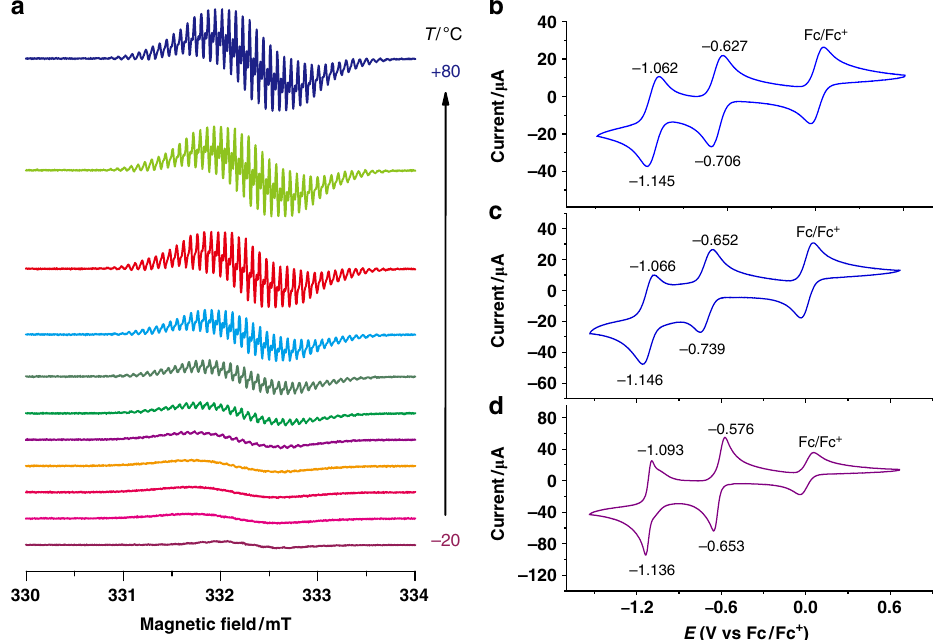
Fig. 5 EPR characterization. a EPR Spectra recorded in 10 degree interval on a 1:1 molar mixture of CBPQT 2( + (cid:129) ) and 1 2( + (cid:129) ) (0.50 mM each) in MeCN.